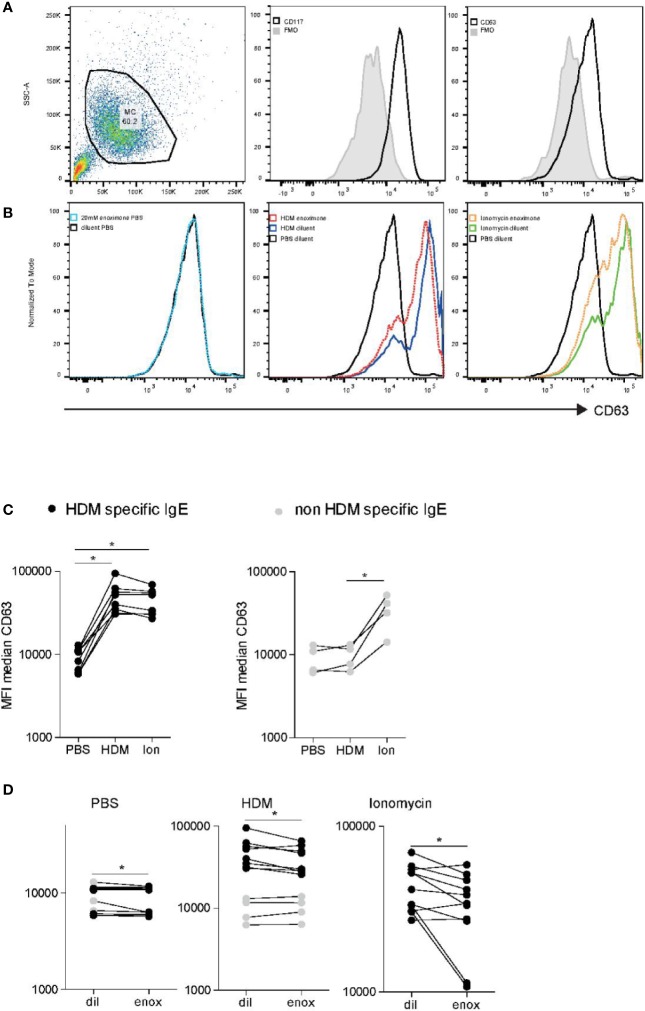
FcεR-mediated activation of human mast cell (HuMC) is impaired when PDE3 is targeted. (A) Flow cytometry analysis of cultured HuMC, gated on the basis of forward and side scatter characteristics. Histograms overlays show flow cytometry (FACS) plot and dot plots graphs illustrating the expression of CD117 and CD63, as indicated. (B) CD63 expression of enoximone (20 mM) pretreated passive sensitized HuMCs PBs control, HDM activated or ionomycin activated. Quantification of HDM-specific serum immunoglobulin E (IgE) [(C) left] or non-HDM specific IgE [(C) right]. CD63 expression of HuMCs treated with enoximone 20 µM and subsequently PBS stimulated [(D) left panel]. CD63 expression of HuMCs treated with enoximone 20 µM and subsequently HDM stimulated [(D) middle panel] or ionomycine stimulated [(D) right panel]. A Wilcox signed test was used; *P < 0.05. Data are shown from one out of two independent experiments. MFI, median fluorescence intensity; HDM, house dust mite.